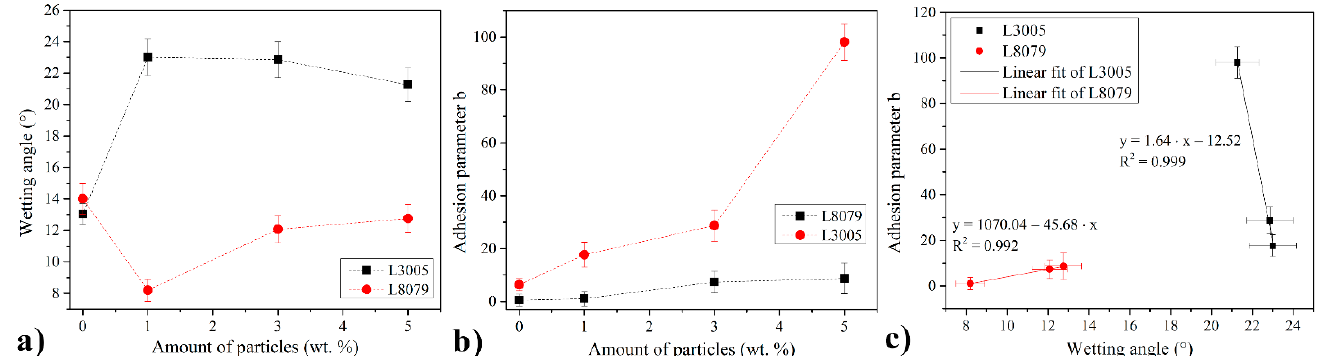
Figure 3. ( a ) Wetting angles of BT with different amount of Mn-Al LDH for the two substrates L3005 and L8079, ( b ) the adhesion parameter b , and ( c ) linear fit of adhesion parameter b vs. wetting angle scatter diagram for the two substrates L3005 and L8079 (Note: In Figure 3c the data for neat BT were omitted due to the different adhesion mechanism with Al substrates as compared to composite adhesives.).